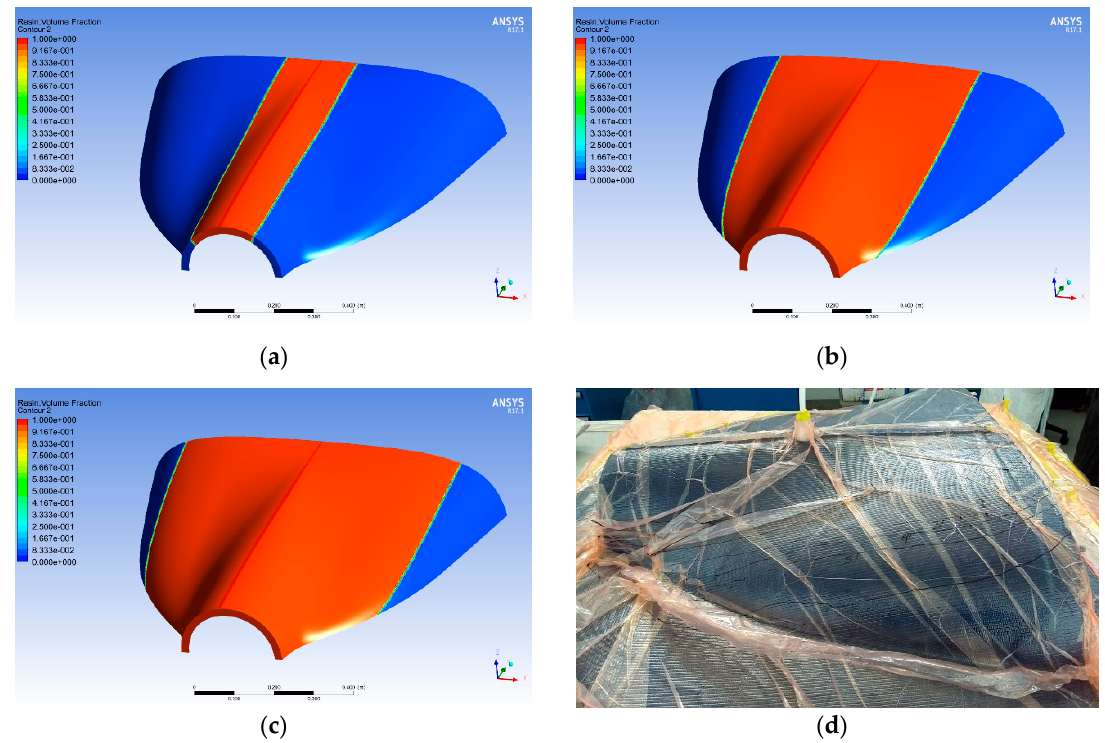
Figure 10. Results from the computational simulation of the resin impregnation process for the upper cowling using C-1 configuration: ( a ) t = 21 s; ( b ) t = 250 s; ( c ) t = 500 s and ( d ) resin infusion of cowling.